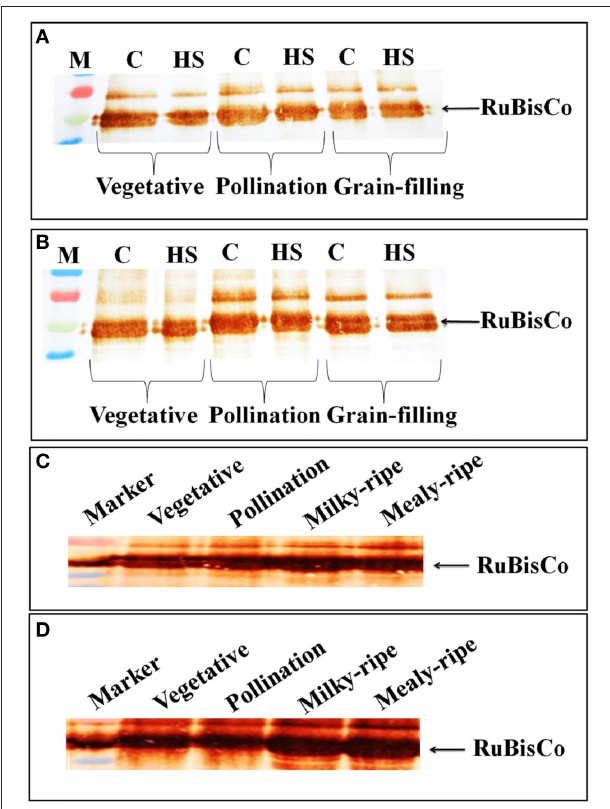
FIGURE 8 | Accumulation pattern of RuBisCo in wheat at different stages of growth and under heat stress. (A) RuBisCo accumulation in HD2329 under control and HS, (B) RuBisCo accumulation in HD2985 under control and HS, (C) RuBisCo accumulation in HD2985 at different stages of growth, (D) RuBisCo accumulation in HD2329 at different stages of growth; C − 22 ± 3 ◦ , heat stress − 42 ◦ C for 2 h; Polyclonal antibody (anti-RuBisCo) was used along with HRP-conjugated secondary antibody; different letters above each bar indicate a significant difference ( p < 0.05 ) between the treatments (one-way ANOVA); vertical bars indicate SE ( n = 3